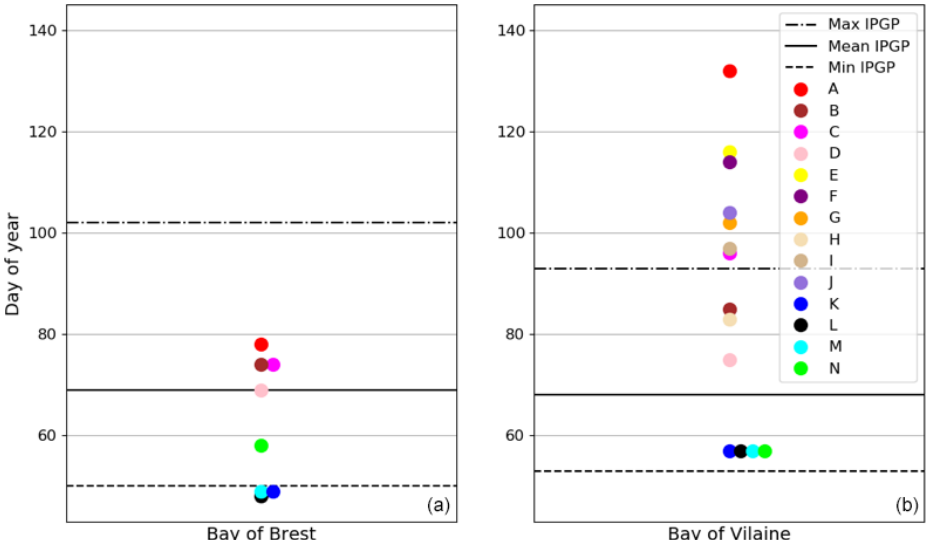
Figure 9. Influence of combined environmental parameters for the MARS-1DV model in both bays (Bay of Brest, a , and Bay of Vilaine, b ) with detailed experiments in Table 2.